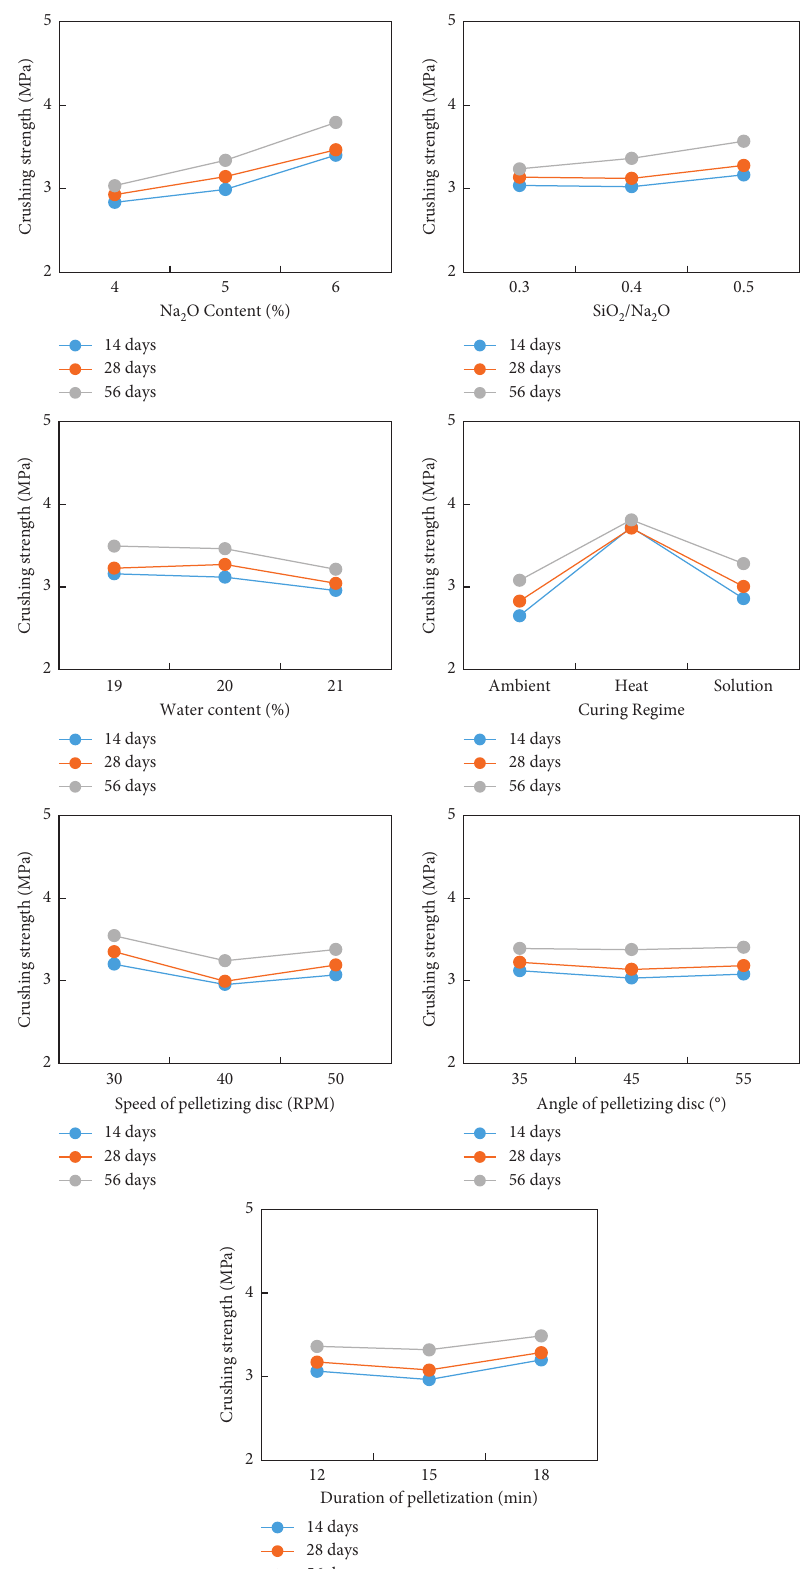
Figure 6: Response index relationship for crushing strength of individual pellets with combined